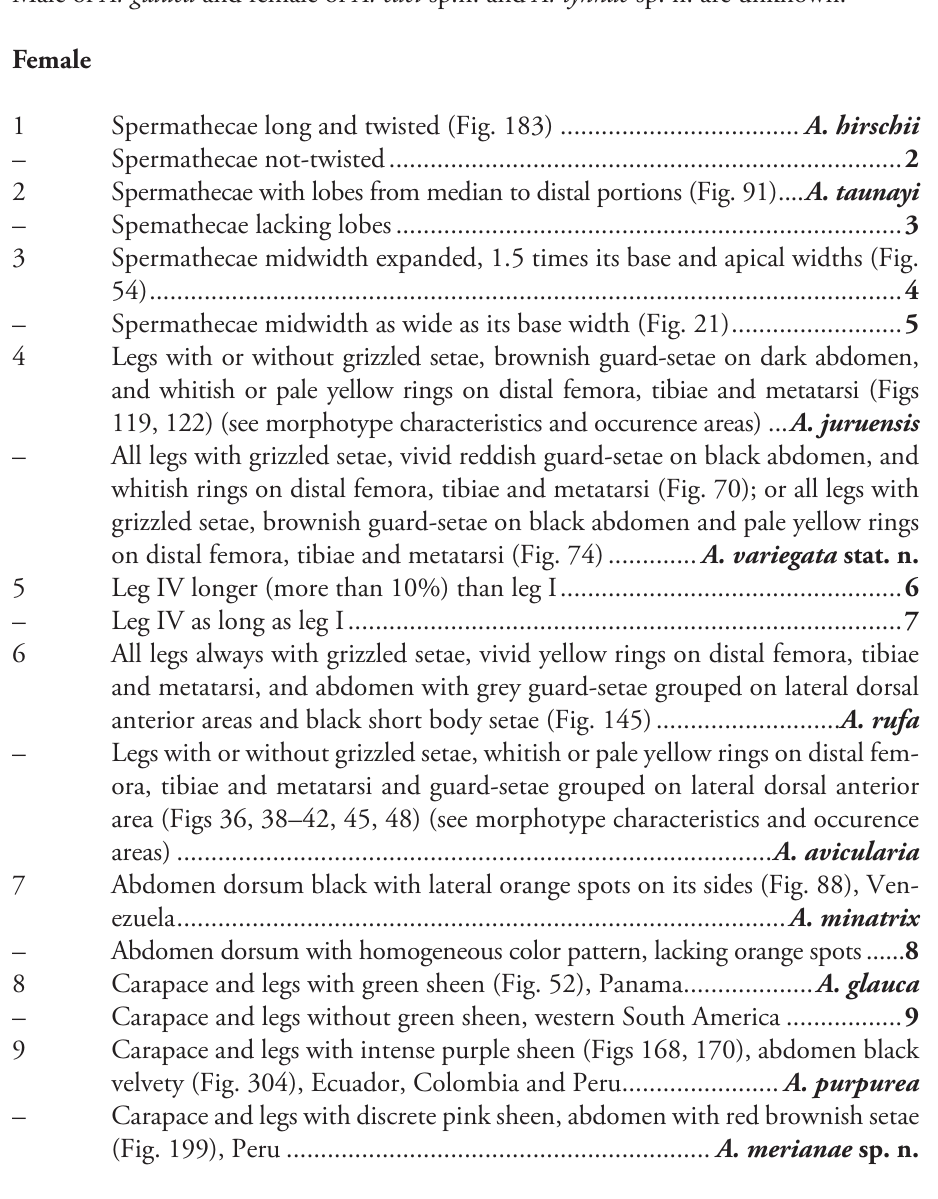
All legs always with grizzled setae, vivid yellow rings on distal femora, tibiae and metatarsi, and abdomen with grey guard-setae grouped on lateral dorsal anterior areas and black short body setae (Fig. 145) ........................... A. rufa – Legs with or without grizzled setae, whitish or pale yellow rings on distal fem- ora, tibiae and metatarsi and guard-setae grouped on lateral dorsal anterior area (Figs 36, 38–42, 45, 48) (see morphotype characteristics and occurence areas) ....................................................................................... A. avicularia 7 Abdomen dorsum black with lateral orange spots on its sides (Fig. 88), Ven- ezuela ......................................................................................... A. minatrix – Abdomen dorsum with homogeneous color pattern, lacking orange spots ...... 8 Carapace and legs with green sheen (Fig. 52), Panama ................... A. glauca – 9 Carapace and legs with intense purple sheen (Figs 168, 170), abdomen black velvety (Fig. 304), Ecuador, Colombia and Peru ....................... A. purpurea – Carapace and legs with discrete pink sheen, abdomen with red brownish setae (Fig. 199), Peru .............................................................. A. merianae sp.